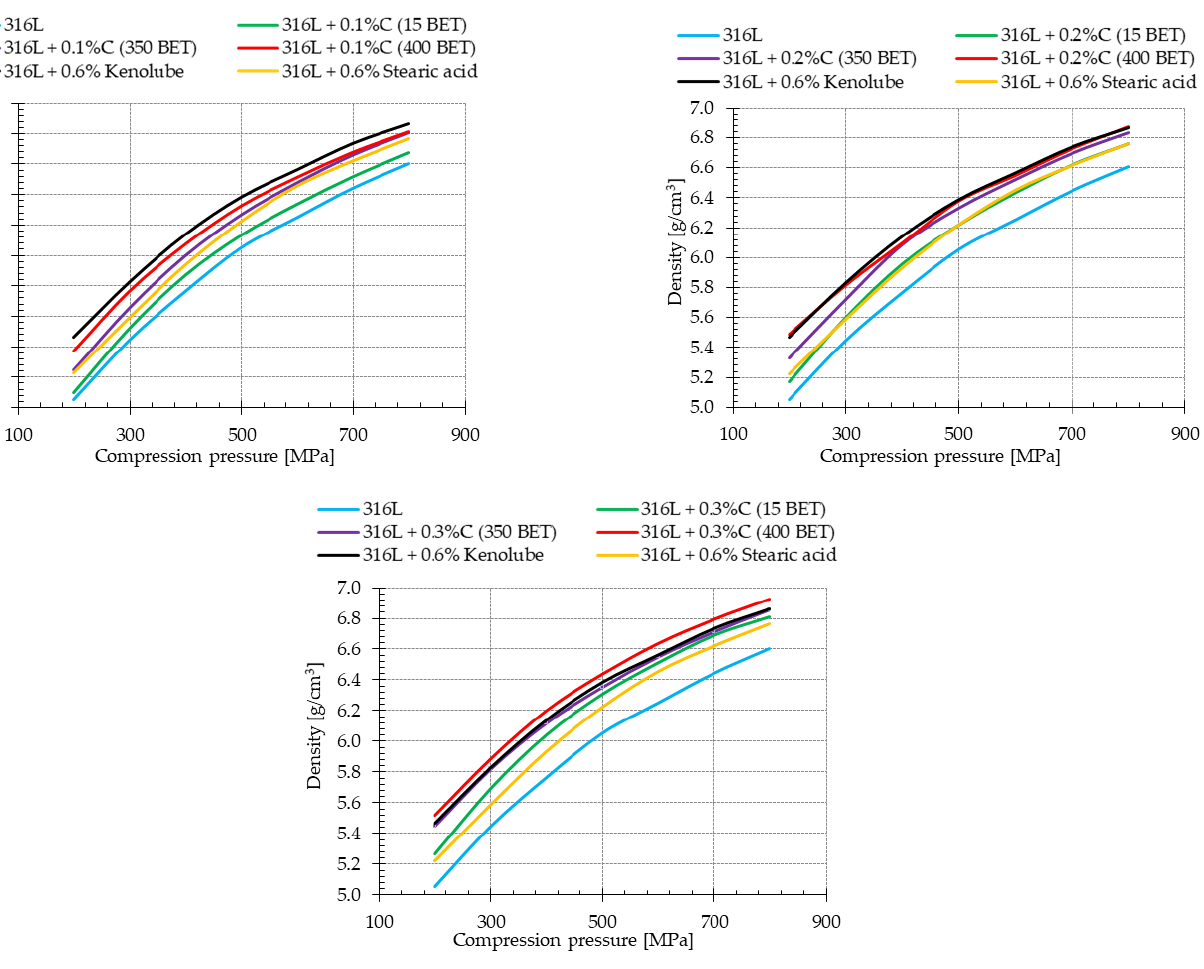
Figure 2. Density curves for pure powder of AISI 316L austenitic stainless steel and mixtures of this powder with additions of graphite powders and slip agents.